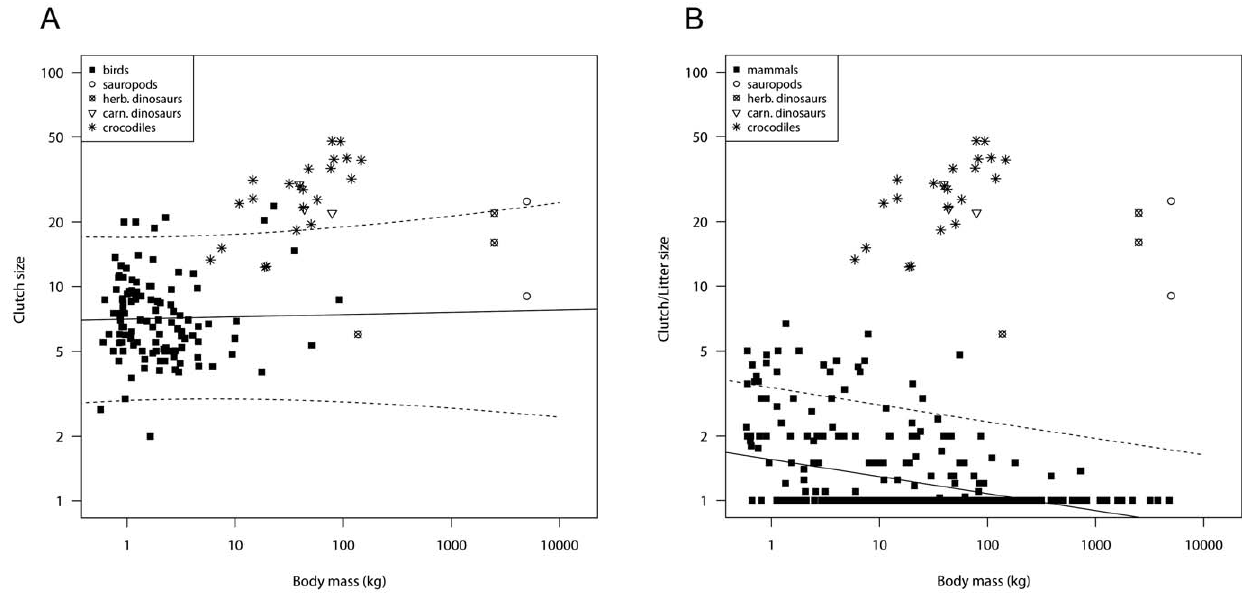
Figure 3. Relationship between clutch/litter size and body mass. (A) in birds, (B) in mammals. Presented are least square regressions (solid lines) and the corresponding 95% confidence intervals (dashed lines, in B only the upper limit of the confidence interval is drawn). Sauropod clutch sizes (open circles) fit well to those of birds or lay somewhat above the upper limit of the confidence interval (A), but do not fit to litter sizes of mammals (B). Carnivorous (open triangles) and other herbivorous dinosaurs (circles with crosses) also fit better to clutch sizes of birds (A) than to litter sizes of mammals (B). Clutch sizes and body masses of dinosaurs are summarized in Table S3. For comparison, clutch sizes of crocodiles were also included (stars). Clutch sizes and body masses of crocodiles are derived from [70].